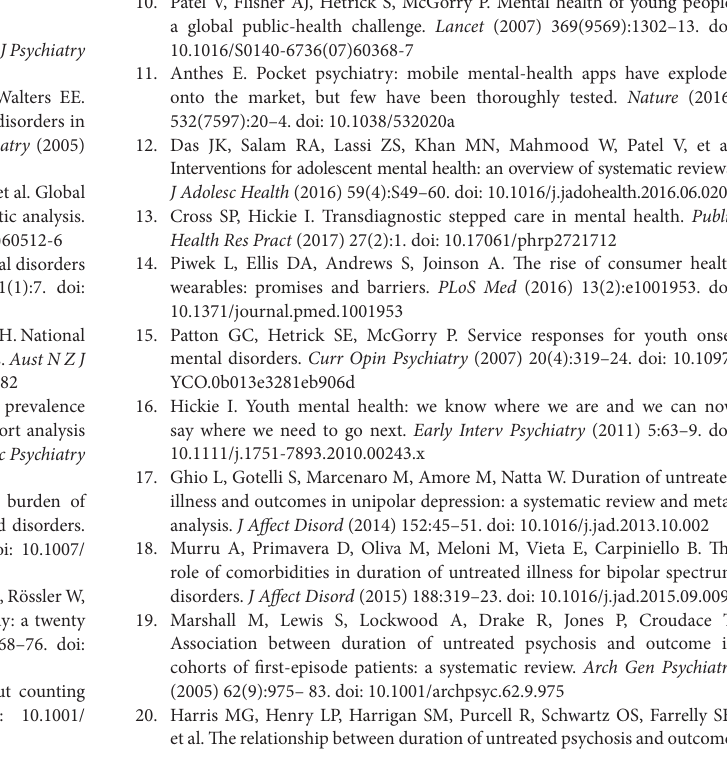
Figure 3 icon acknowledgment: “Computer” by Nikita Kozin from the Noun Project; “Alarm” icon made by Freepik from